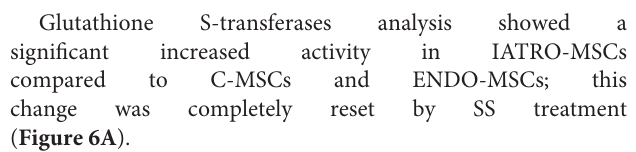
Glutathione S-transferases